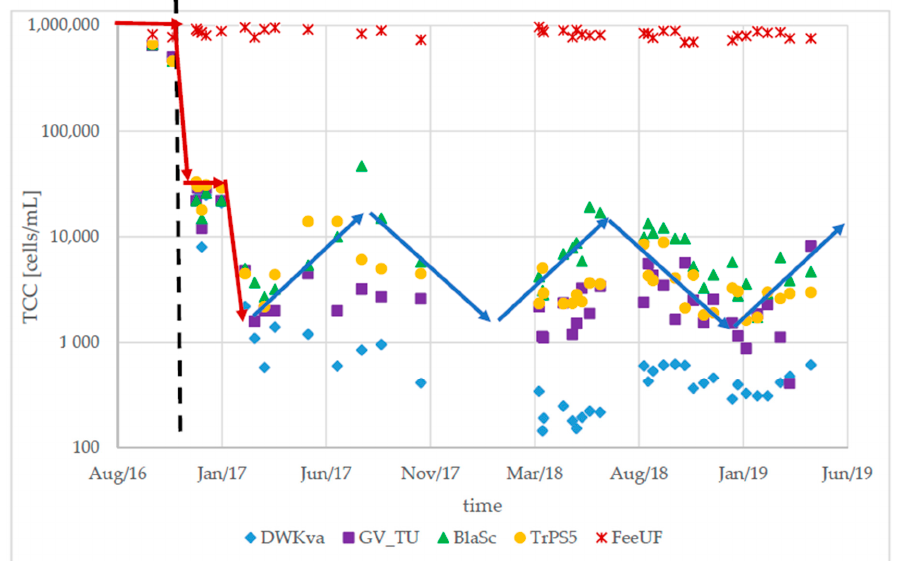
Figure 1. Total cell count (TCC) in water from the drinking water treatment plant (DWTP) and drinking water distribution system (DWDS). TCC was measured in the feed water to the ultrafiltration (UF) membrane (FeeUF, red stars); outgoing drinking water (DWKva, blue diamonds); and distributed water at an o ffi ce building located at WWTP Getteröverket (GV_TU, purple squares), a public school in Bläshammar (BlaSc, green triangles), and a pump station in Trönningenäs (TrPS5, yellow circles). Measurements were taken before and after the installation of UF, indicated by the vertical dashed line. The red arrows show changes of TCC before, during, and shortly after commissioning of UF; blue arrows indicate seasonal changes in TCC. The graph includes published data (until January 2017,